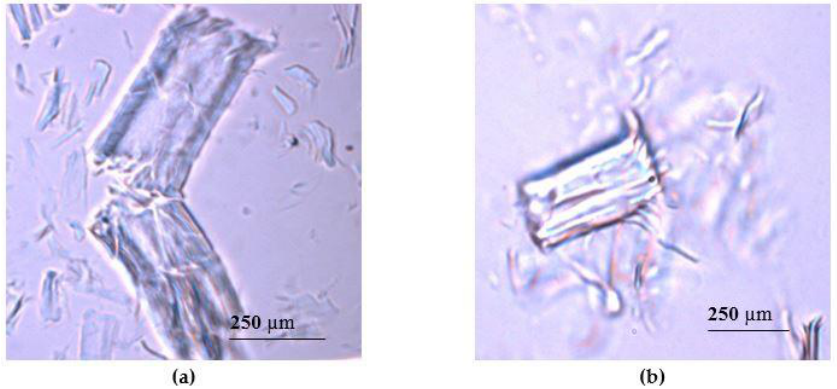
Figure 1. Bleached birch Kraft pulp fibers in an optical microscope ( a ) after ammonium persulfate (APS) treatment; ( b ) after APS treatment followed by three cycles of mechanical treatment in a high shear mixer and ultrasound